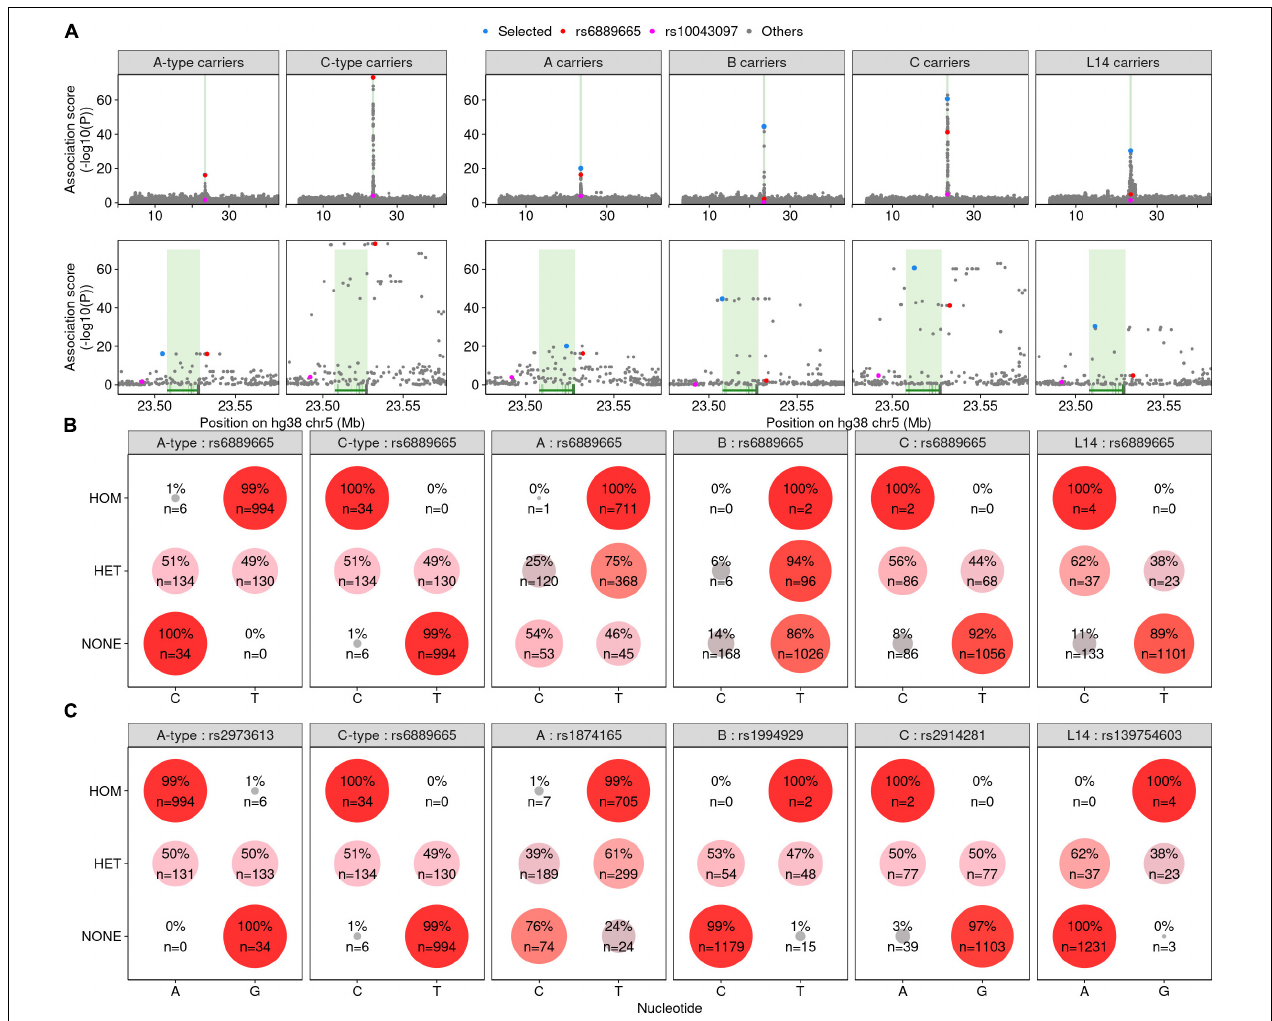
FIGURE 3 | Single-nucleotide polymorphisms (SNPs) are associated with different PRDM9 alleles. (A) Association scores for all SNPs in a ± 20-Mb window around the PRDM9 locus (see “Materials and Methods”). The PRDM9 genotype examined is given in the title of each panel (individuals carrying at least one copy of A -type, C -type, A , B , C, or L14 PRDM9 alleles, respectively). SNPs previously shown to be linked to recombination patterns in African populations (Hinch et al., 2011) are marked in red (rs6889665) and pink (rs10043097). Lower panels show a magnified view around the peak in the association signal at PRDM9 . The PRDM9 gene is indicated by green shading. (B) Assessment of the prevalence of rs6889665 alleles. Individuals were classified as homozygous (HOM), heterozygous (HET), or non-carriers (NONE) of the PRDM9 allele indicated in gray in the column header. The prevalence of the C and T alleles of rs6889665 were assessed in each group. Larger circle size and deeper red color indicate a higher prevalence. (C) Similar to (B) , but for the best-scoring SNP [blue in panel (A) ] for each PRDM9 genotype we